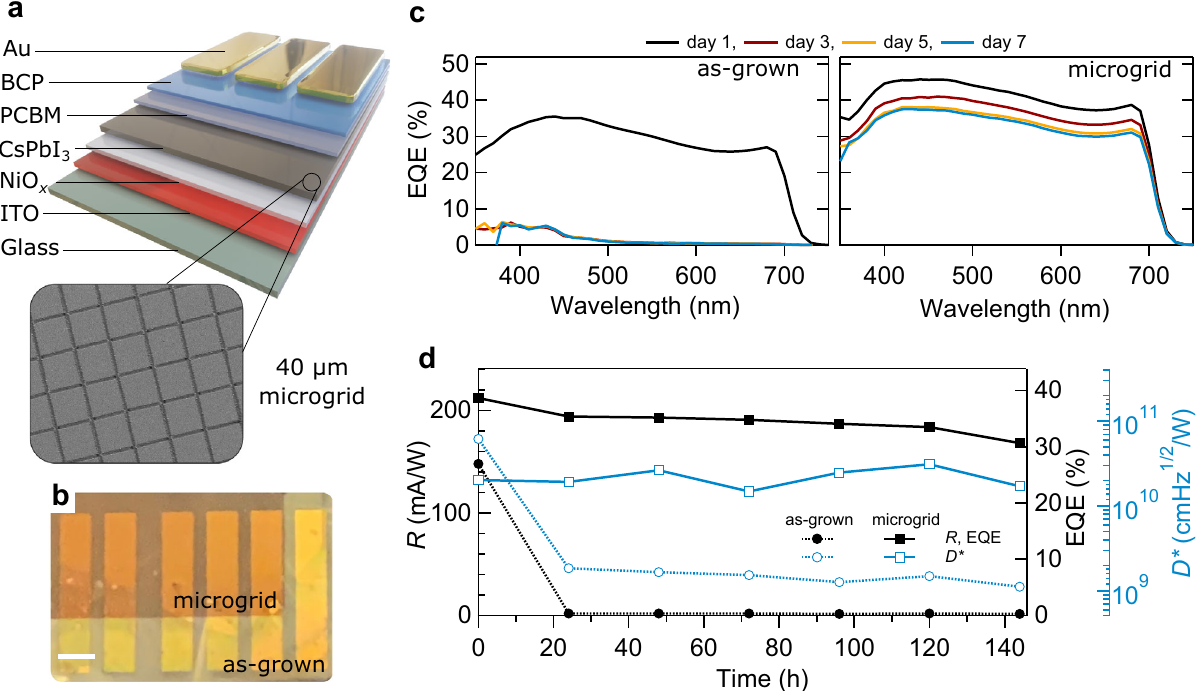
Fig. 4 | An embedded microgrid stabilizes CsPbI 3 perovskite photodetectors. a Schematicillustrationofdevicearchitecturewithascanningelectronmicroscopy (SEM)imageoftheactiveperovskitelayerwithanembedded40 μ mmicrogrid.This inverted p-i-n type device architecturewaschosen with indium tin oxide(ITO)/NiO x acting as the anode and the phenyl-C 61-butyric acid methyl ester/bathocuproine (PCBM/BCP) layers acting as the cathode. b photograph (after fi rst 24h of ambient